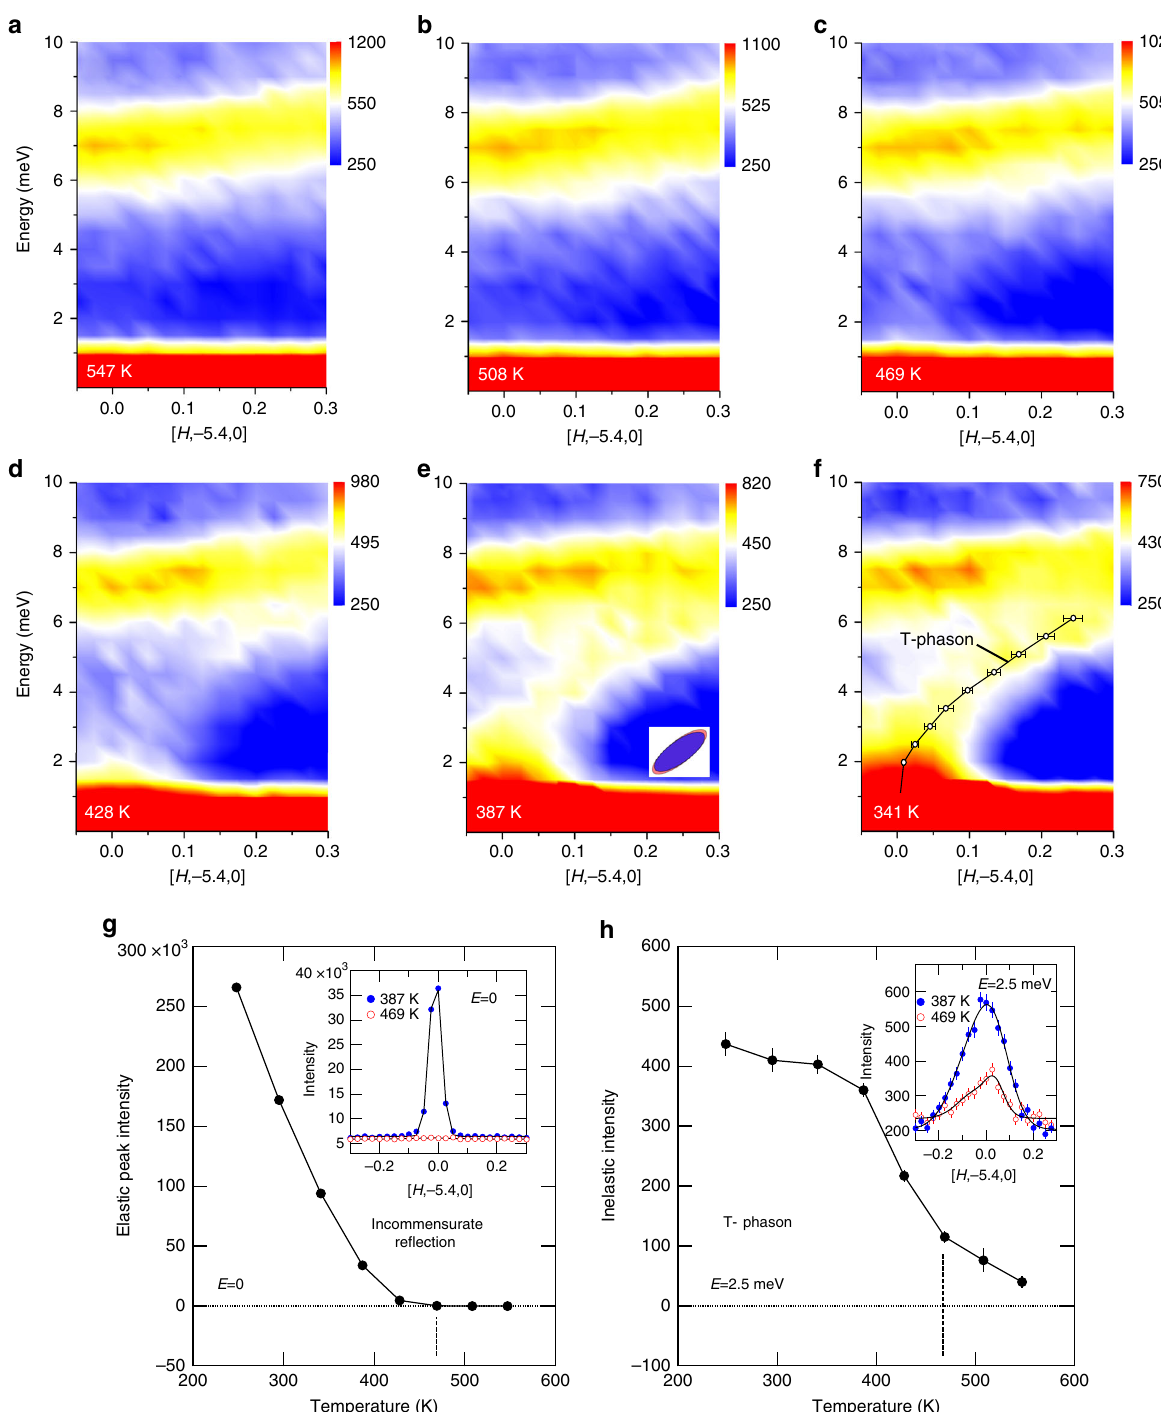
Fig. 3 Phason formation measured on a triple-axis spectrometer. These measurements provide a detailed assessment of the temperature dependence of the phason and incommensurate re fl ection in a focused region of Q - E space along Q = [ H , − 5.4, 0]. a – f Formation of the (0, − 5.4, 0) phason on cooling below the incommensurate phase transition. The tilted ellipsoid inset in e indicates the instrument resolution function. g Shows the temperature dependence of the incommensurate re fl ection intensity measured at the elastic line ( E = 0), and h shows the temperature dependence of the phason intensity measured at E = 2.5 meV. Uncertainties are statistical and represent one where v α is the group velocity of the mode q s , τ α is the mode q s q s is the mode heat capacity, lifetime for transport in direction α , C q s and V is volume. At high temperatures k T (cid:2) (cid:1) h ω ð B